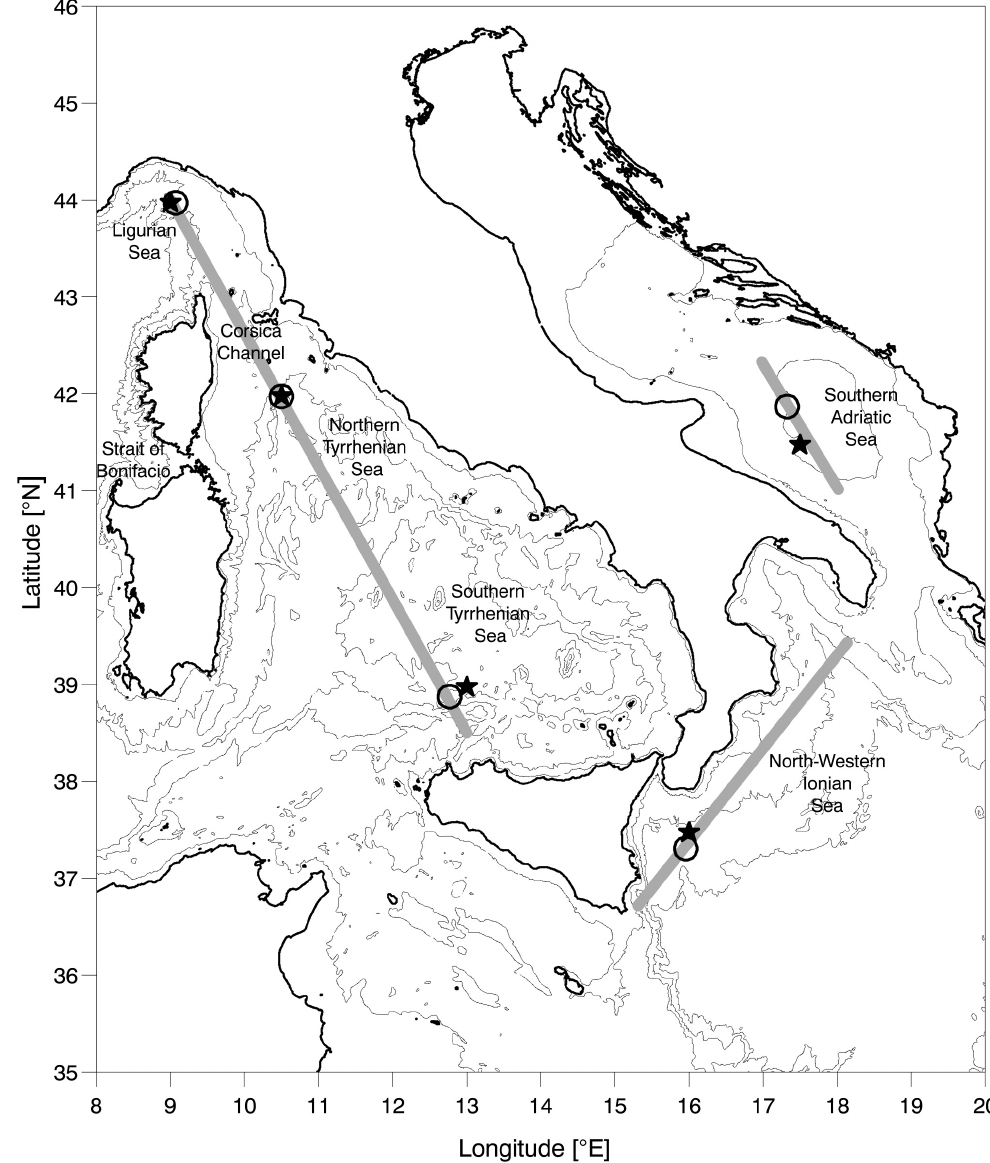
Fig. 1. The bathymetric map of the study area. Light grey strips denote the tracks of XBT deployments. Open circles denote single locations of the XBT temperature profiles representing the five study zones. Asterisks are the grid nodes with ECMWF meteorological data used for the calculation of the air-sea heat